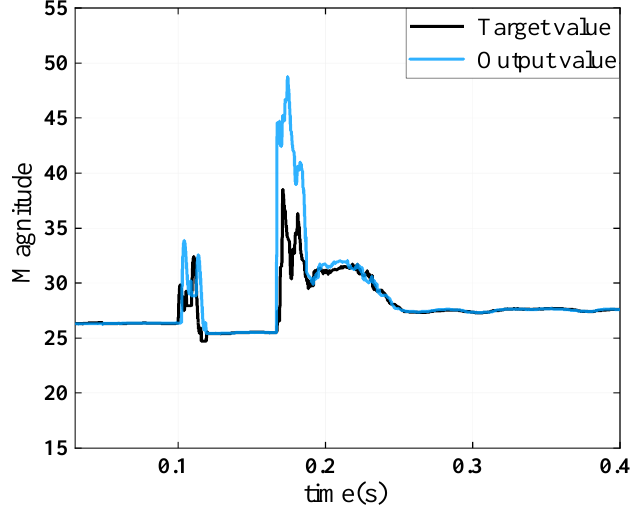
Figure 4. Tracking performance of backstepping controller.